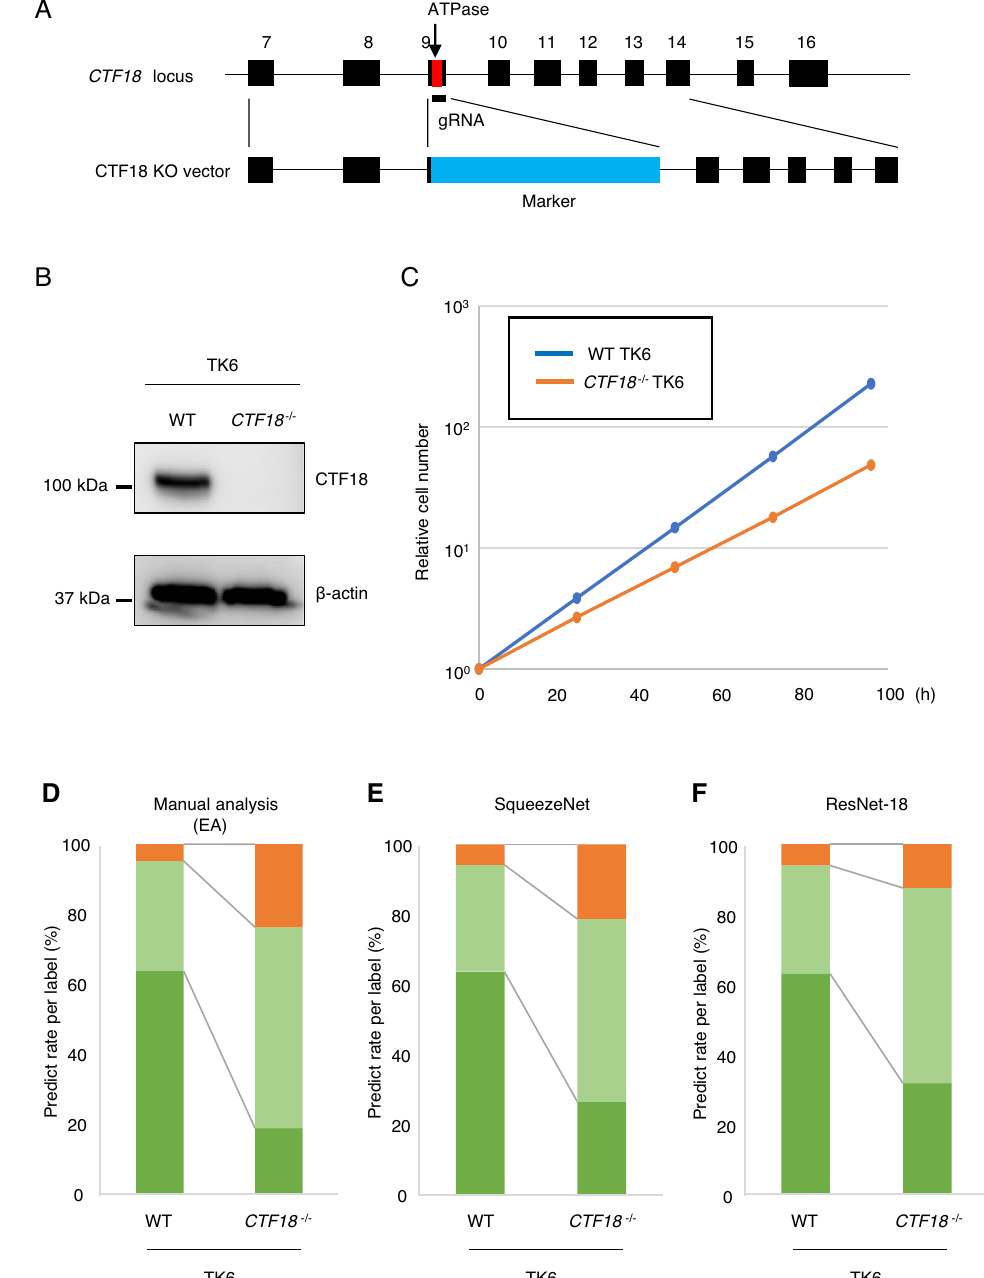
Figure 5. Establishment and analysis of CTF18 -/- TK6 cells. ( A ) Schematic representation of the CTF18 gene locus and gene targeting knockout construct. (Closed boxes) Exons; (Marker) drug resistance genes; (Red box) the sequence encoding the ATPase domain of CTF18. ( B ) Whole-cell lysates were prepared from cells of the indicated genotypes. CTF18 and β -actin (loading control) were detected by Western blotting. ( C ) Growth curves of the indicated cell lines. Cells (1 × 10 5 ) of the indicated genotypes were inoculated in 1 mL of medium, counted, and passaged every 24 h. Distribution of each type of chromosome in WT TK6 and CTF18 -/- TK6 cells. ( D ) EA. ( E ) SqeezeNet. ( F )